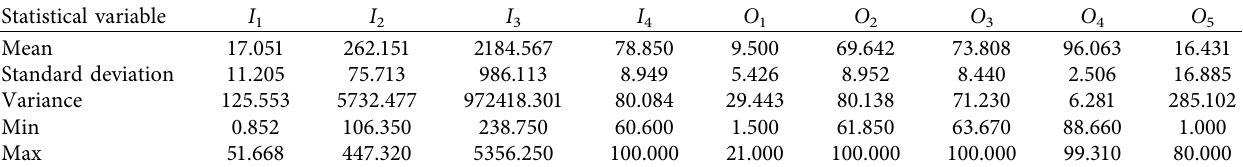
Table 4: Descriptive statistics of teaching efficiency evaluation index